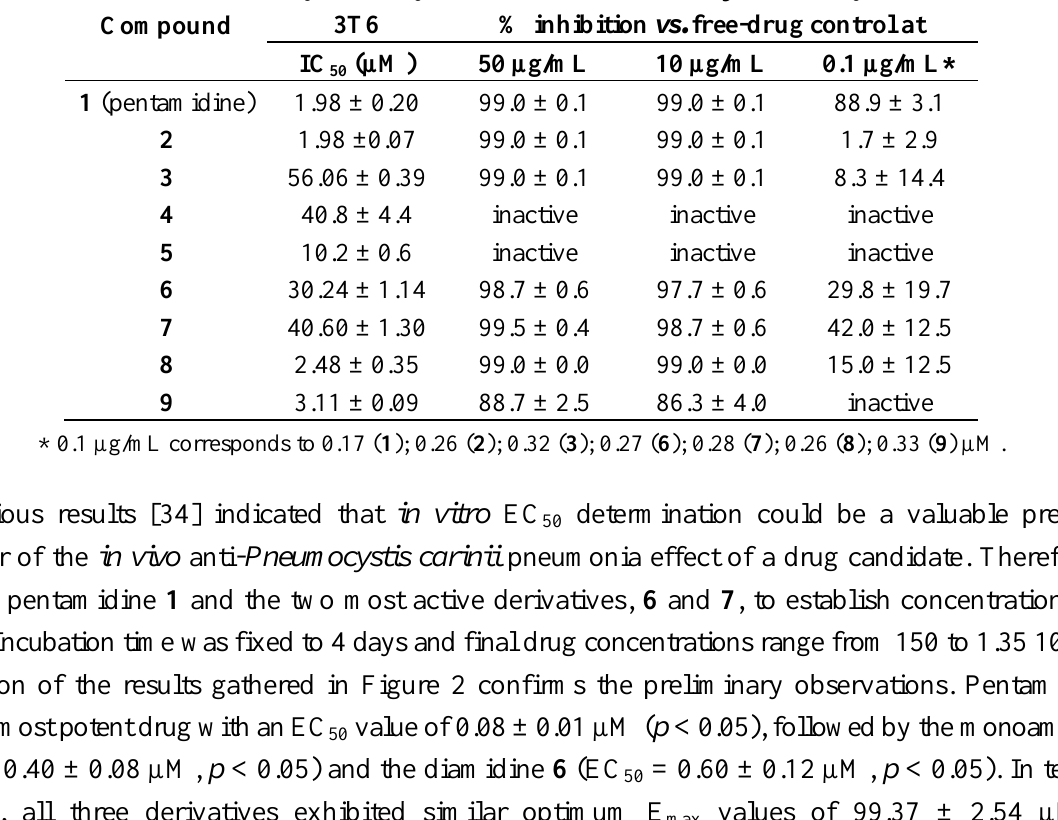
Table 1. Results of the in vitro cytotoxicity and anti- Pneumocystis screenings for derivatives 1 – 9 .